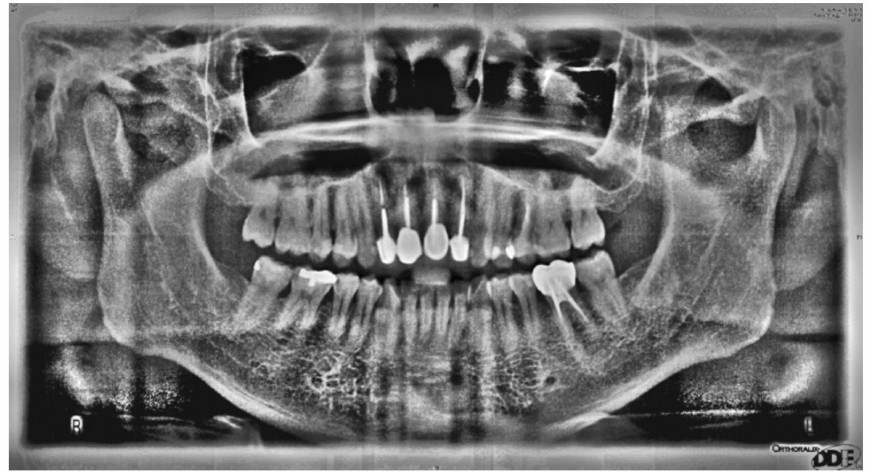
Figure 8. Adaptive histogram